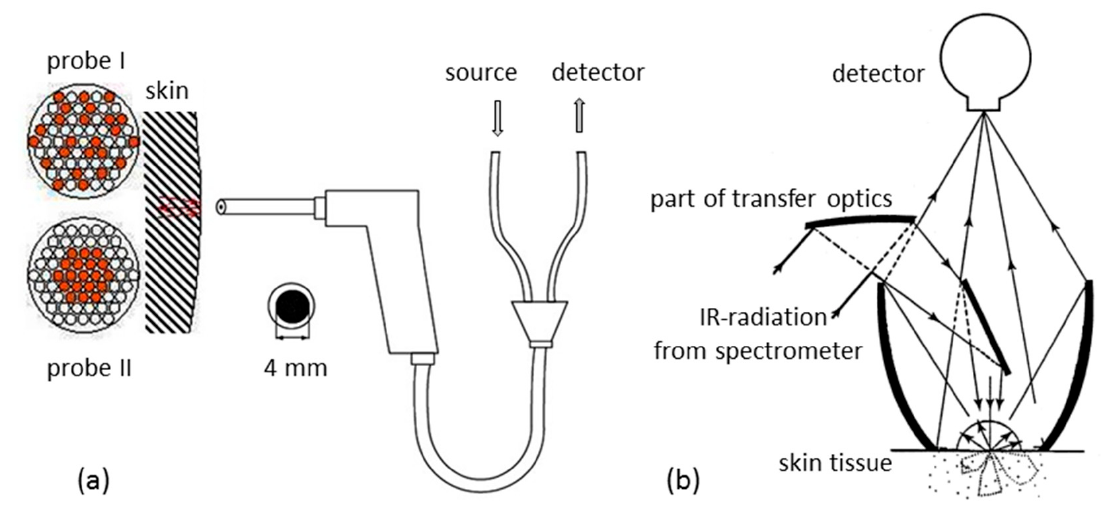
Figure 1. Diffuse reflection accessories used for skin measurements: ( a ) fiber-optic probes with fibers for illumination and detection arranged differently; ( b ) mirror-based device providing tissue spectra with different probing depths.